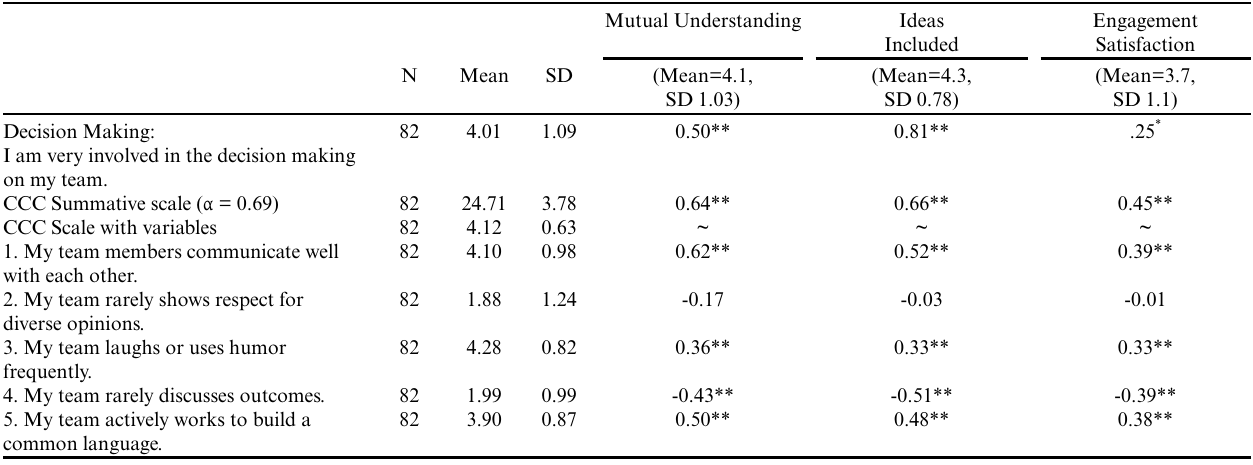
Table 3 . Correlations among process variables, including decision making and collective communication competence (CCC), and outcome variables including mutual understanding of goals, idea inclusion, and satisfaction with stakeholder engagement. Participants were asked to rate their level of agreement or disagreement with statements (1 = Strongly disagree and 5 = Strongly agree).